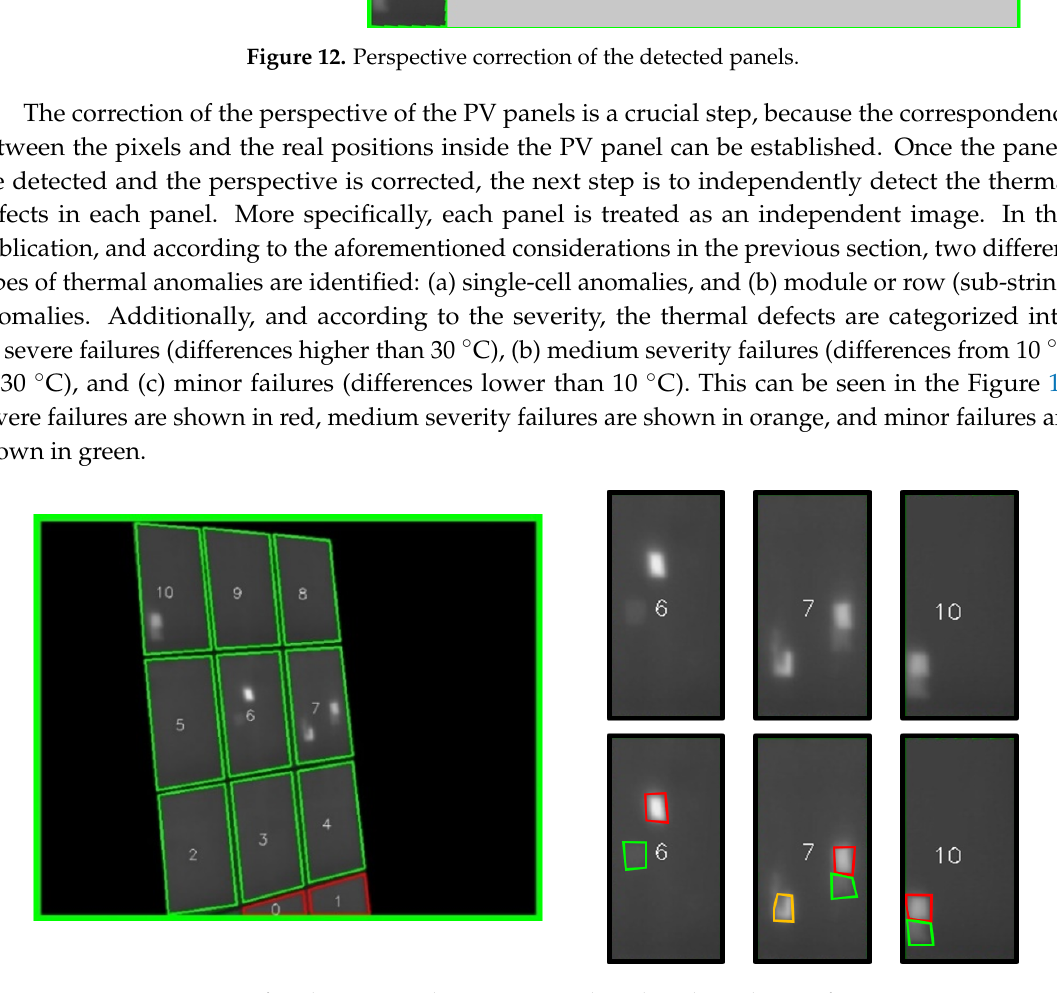
Figure 13. Defect detection and categorization based on three classes of